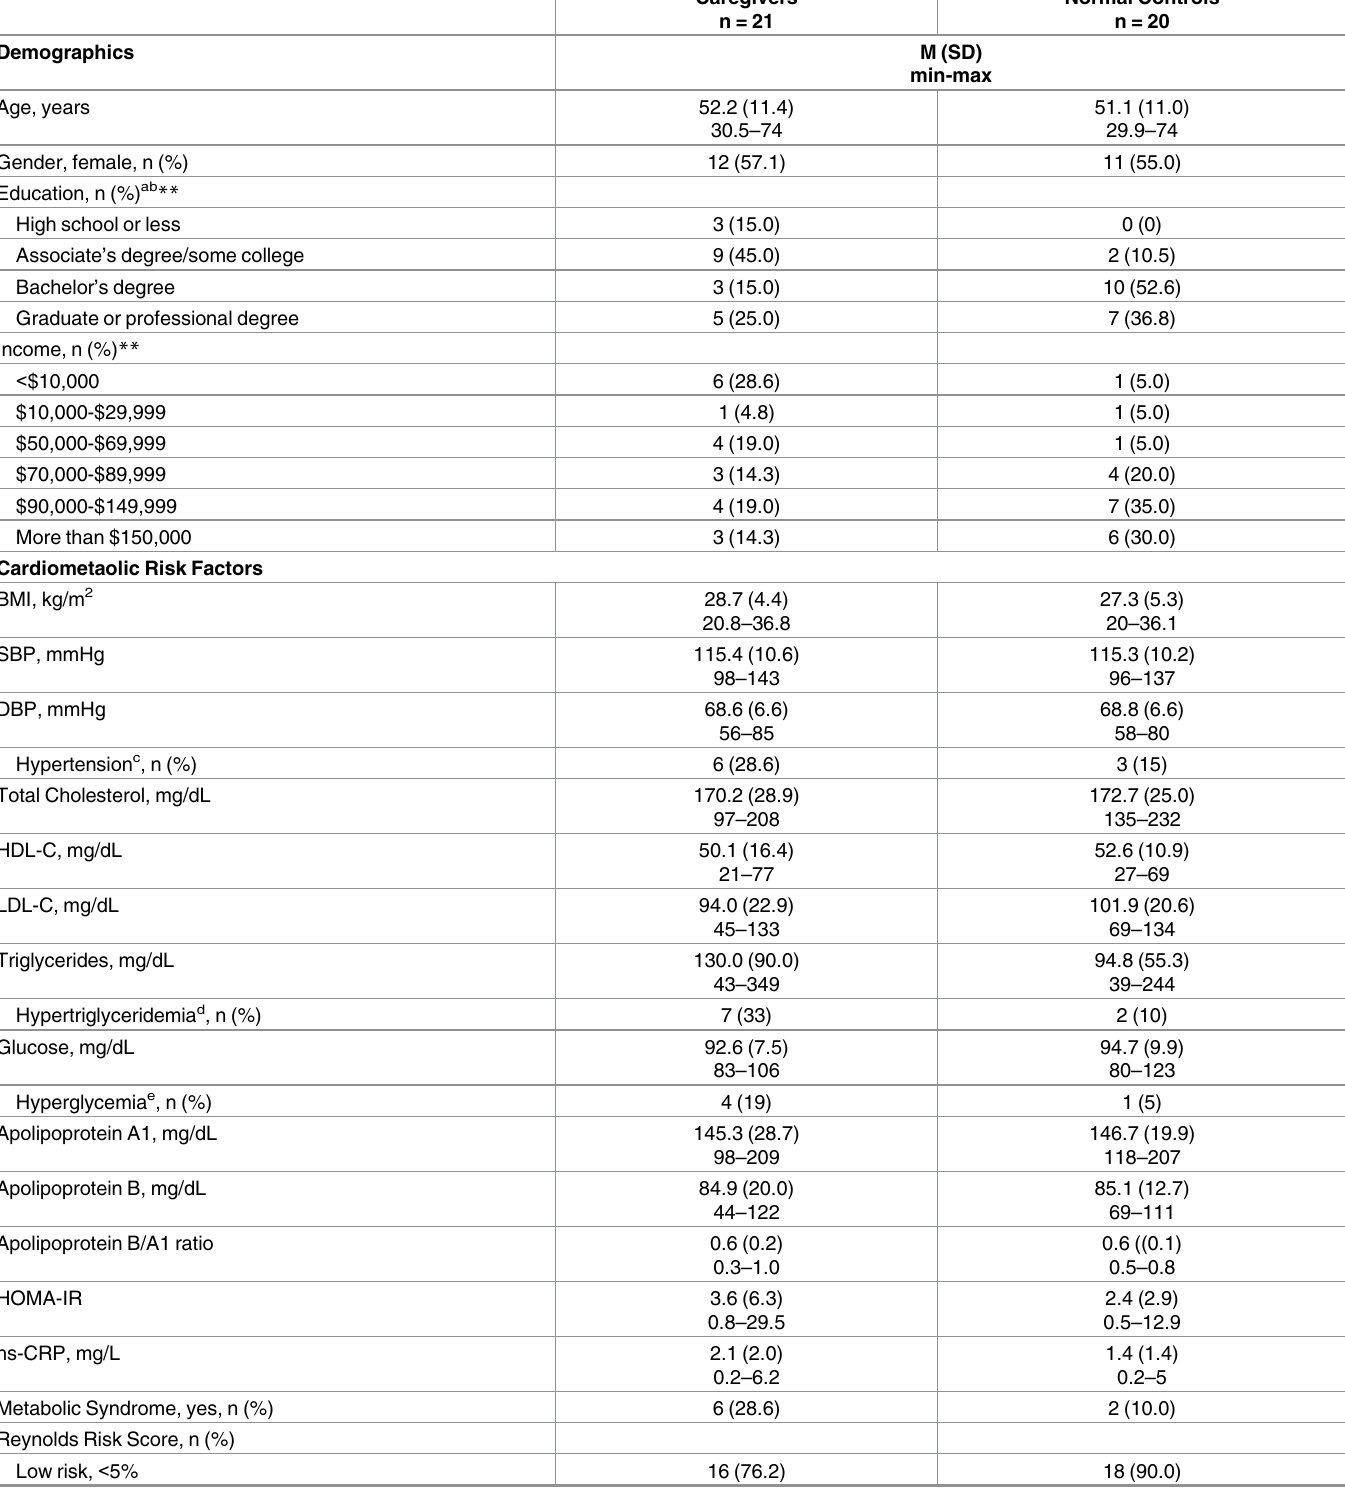
Table 1. Demographics, cardiometabolic risk factors and health behaviors at